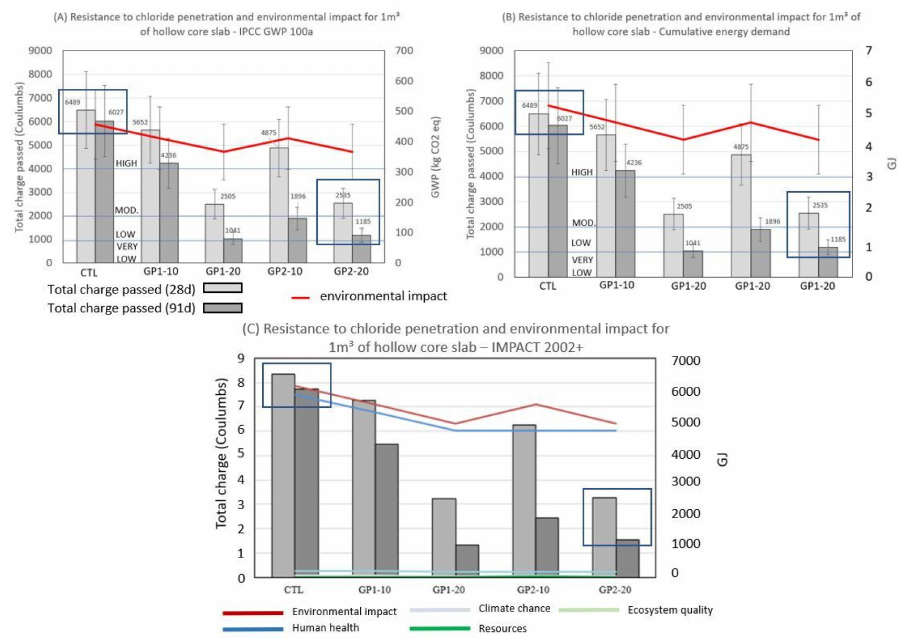
Figure 15. Chloride penetration resistance versus environmental